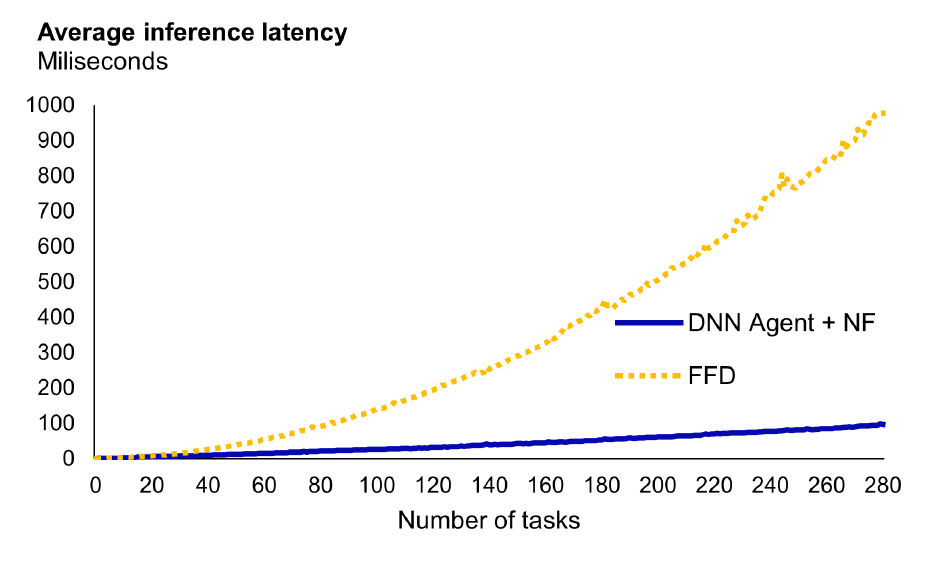
Figure 12. Problem 5 results by size of the input set of